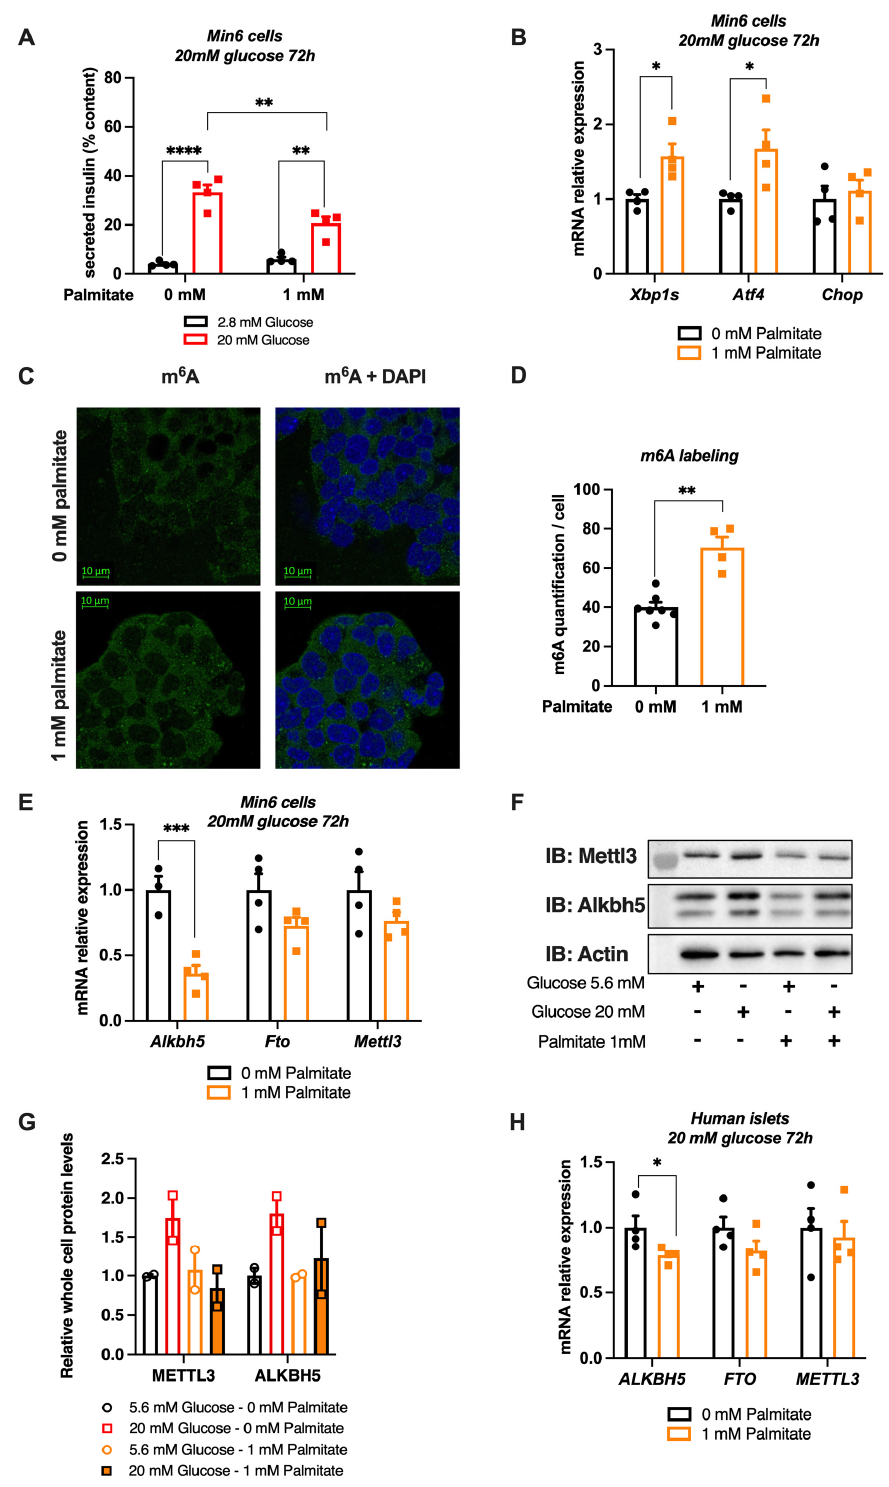
4 Figure 4. Effects of a chronic high glucose and palmitate treatment on m 6 A RNA methylation and m 6 A enzyme expression in Min6 cells and non-diabetic human islets. ( A , B ) Glucose-stimulated insulin secretion was quantified by ELISA (( A ), n = 4) and quantification of mRNA expression levels of some ER stress genes by RT-qPCR (( B ), n = 4) after 20 mM glucose with or without 1 mM palmitate during 72 h. ( C , D ) Immunofluorescence of m 6 A methylation in Min6 cells after after 72 h of 20 mM glucose with or without 1 mM palmitate ( C ) and its quantification ( n ≥ 4, ( D )). ( E ) Quantification